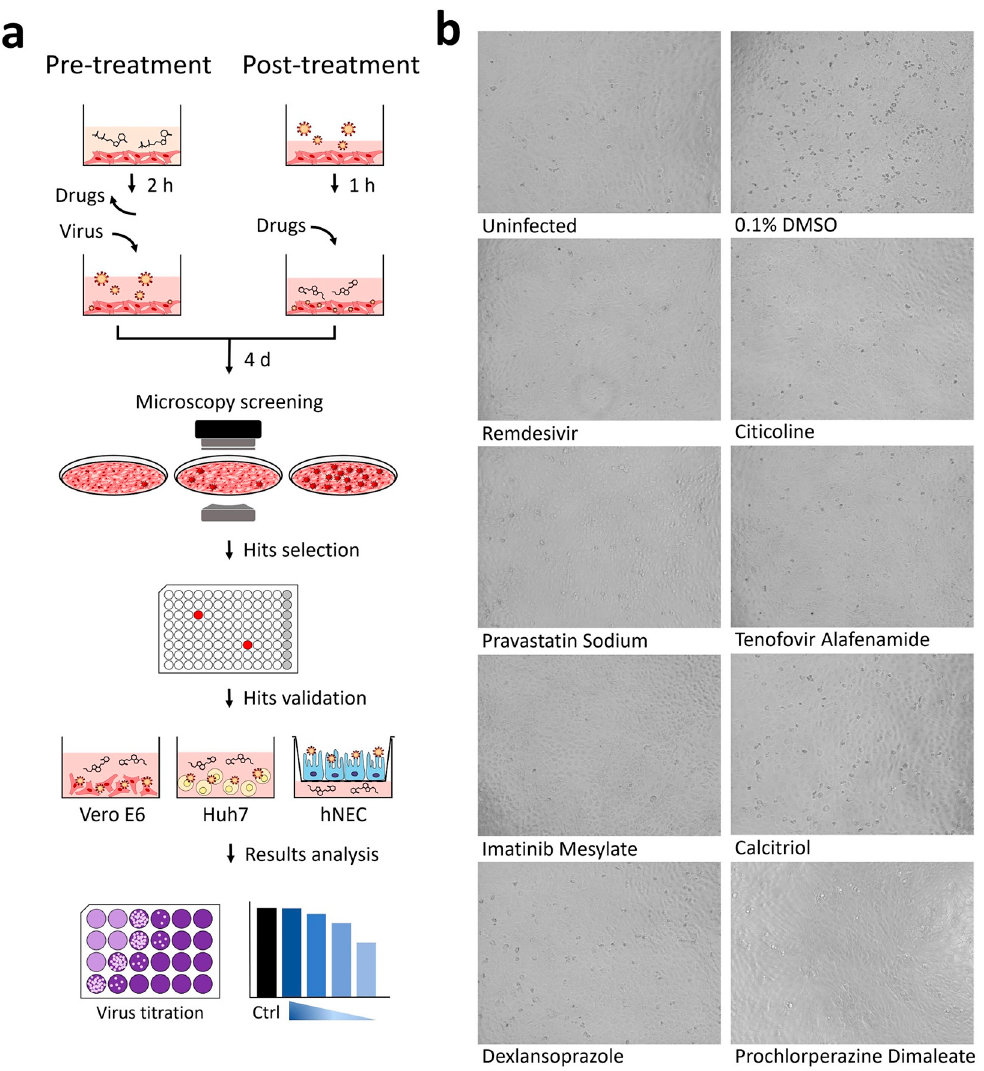
Figure 1. Schematic overview of the anti-SARS-CoV-2 drug screening procedure. ( a ) ACE2 targeted inhibitors and compounds from the natural product library were applied prior to infection with SARS-CoV-2 (pre-infection treatment) while compounds from the FDA-approved library and the flavonoid library were applied post infection (post- infection treatment). Out of 2191 compounds tested, 121 displayed viral CPE reductions and 7 were selected for further validations using Vero E6 and HuH7 cell lines and hNEC. ( b ) Uninfected cells, infected cells treated with 0.1% DMSO, and infected cells treated with remdesivir were included as controls in the screen. Following treatment with citicoline, pravastatin sodium, tenofovir alafenamide, imatinib mesylate, calcitriol, dexlansoprazole, and prochlorperazine dimaleate, reduced CPE was observed when compared to the DMSO